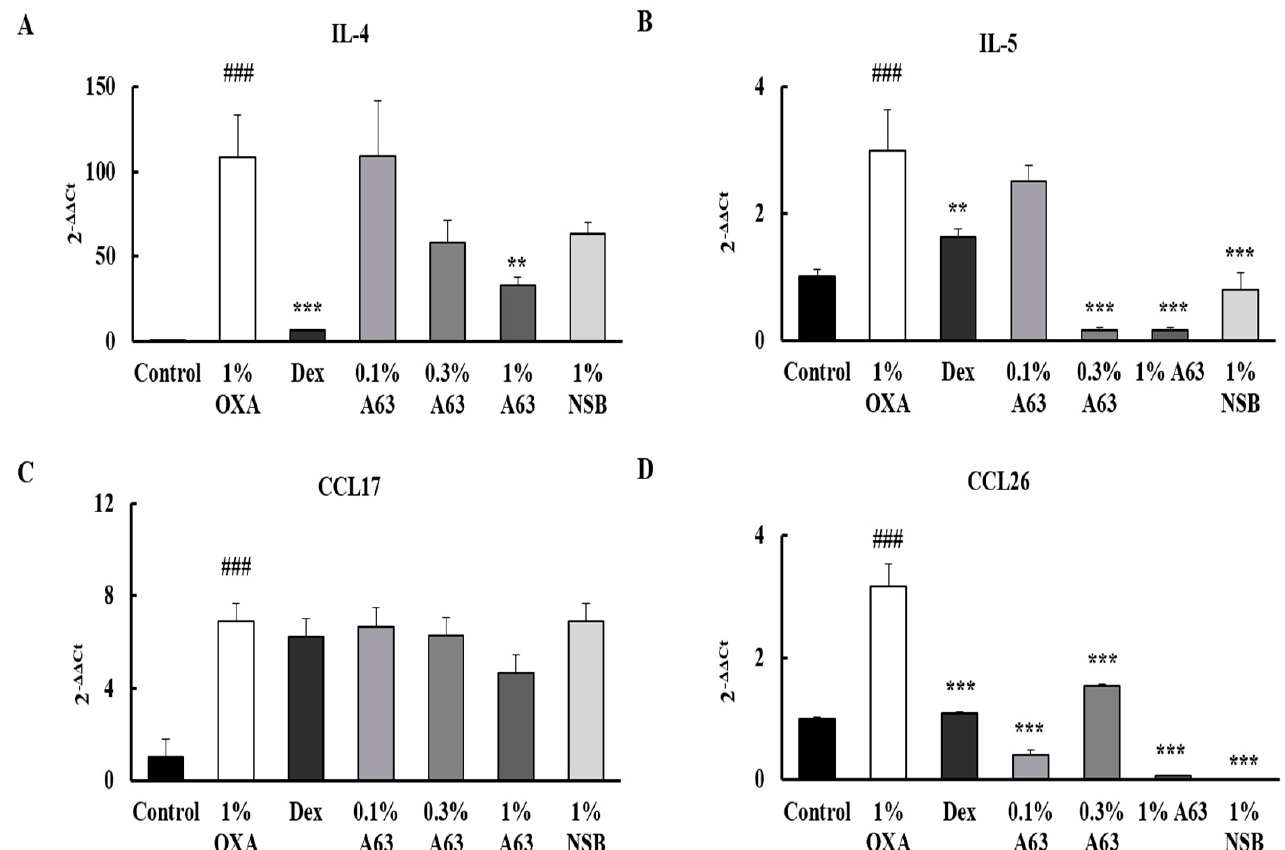
Figure 4. A63 extract suppresses the expression of atopic dermatitis hallmark genes in mouse tissue. qPCR analysis of atopic marker expression in mouse skin. The elevated production of atopic cytokines, IL-4 ( A ), IL-5 ( B ), CCL17 ( C ), and CCL26 ( D ), in OXA-treated groups was modestly suppressed by A63 extract in ear tissue. Results are expressed as mean ± standard deviation (### p < 0.001 versus control group, ** p < 0.01, *** p < 0.001 versus 1% OXA group). OXA, oxazolone.